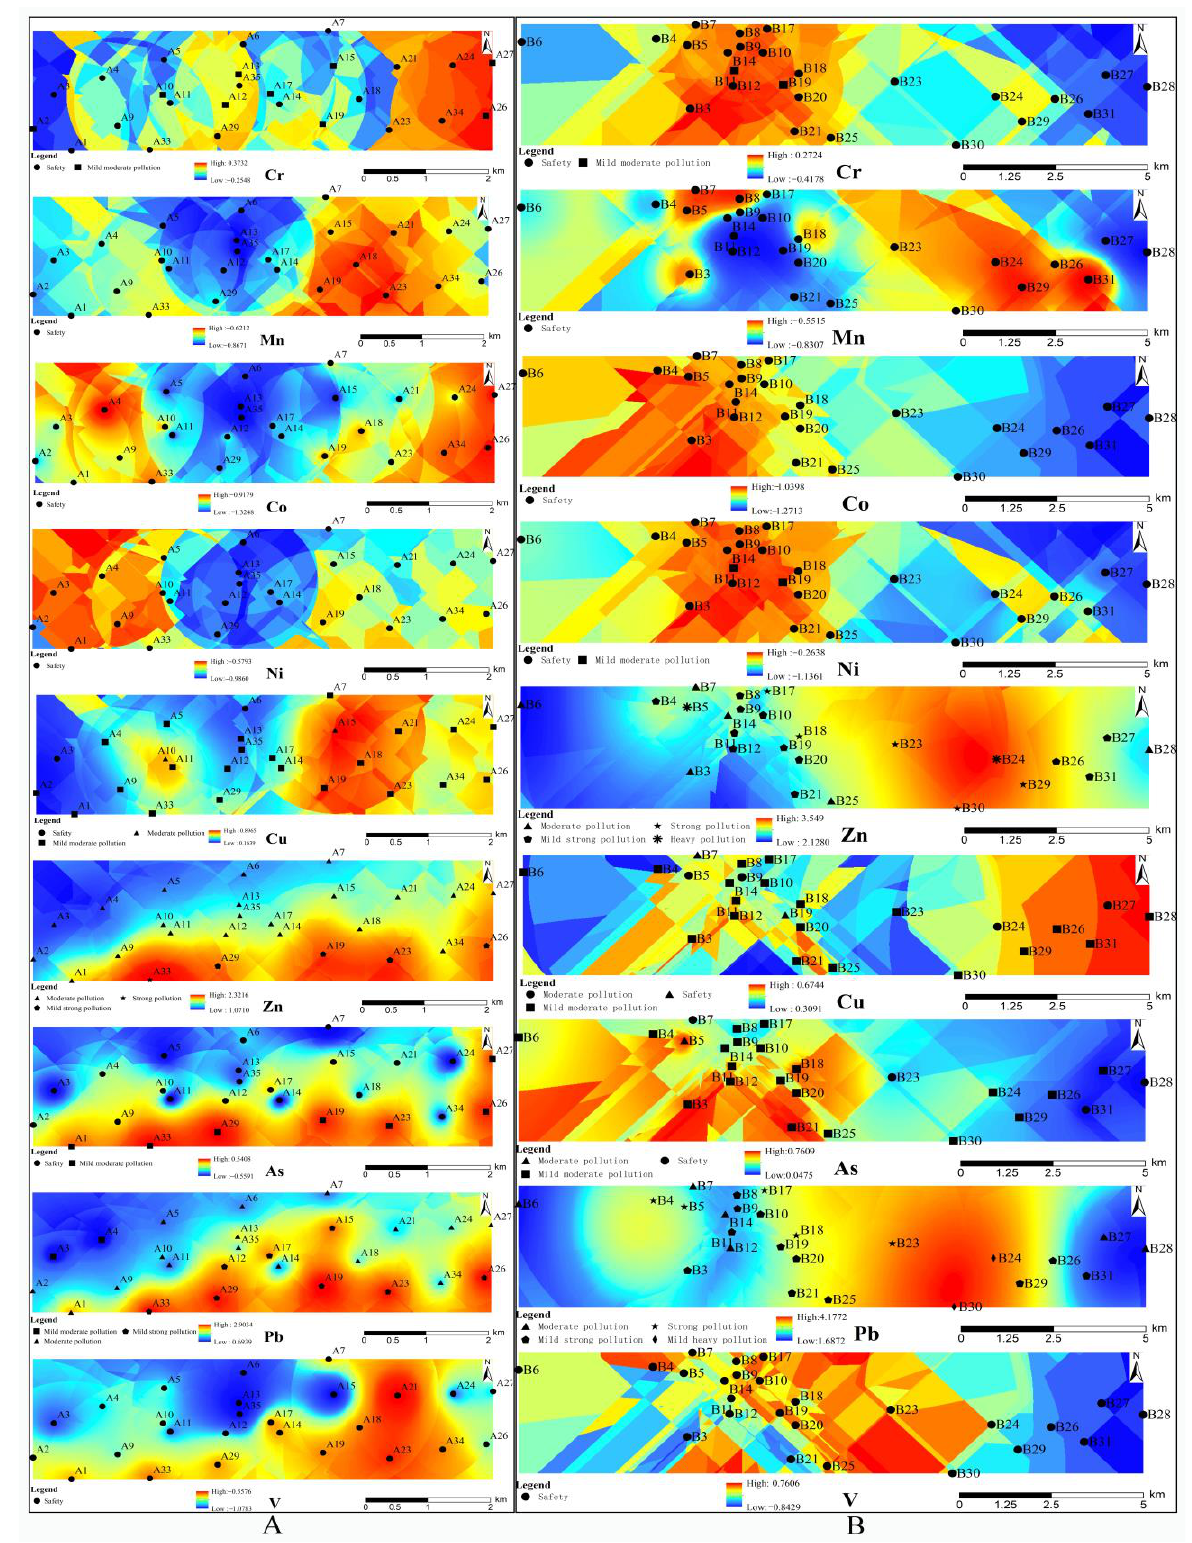
Figure 3. Spatial distribution of urban dust heavy metal geoaccumulation index values and pollution types in Tianshui City. ( A ) Qinzhou District; ( B ) Maiji District.